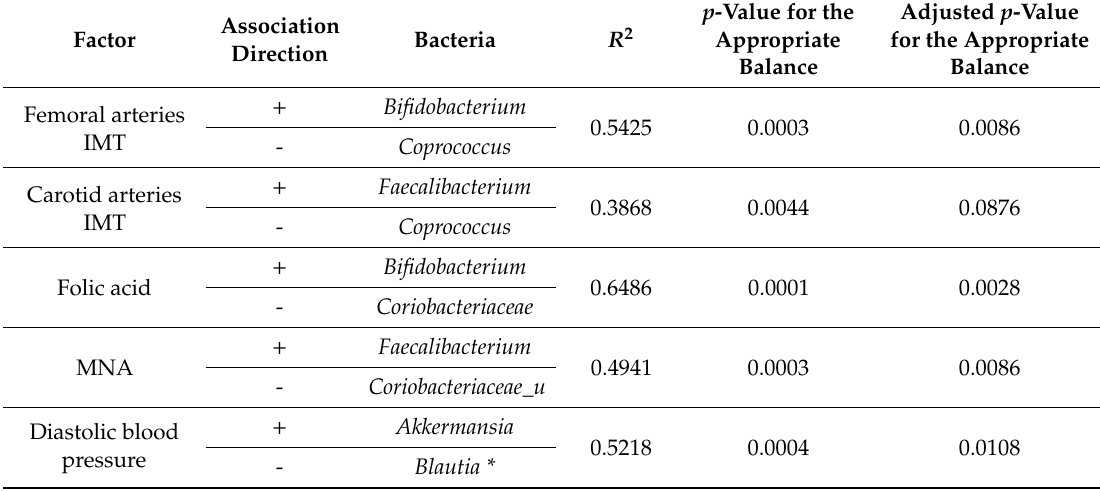
Table 5. Selbal analysis results: the correlation between the gut microbiota composition and the health